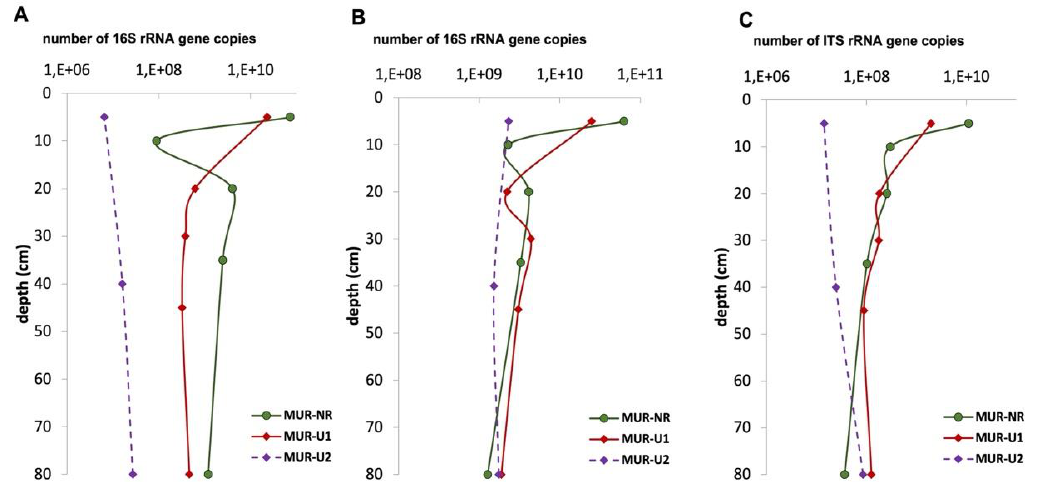
Figure 4. The number of 16S rRNA genes copies of archaea ( A ), bacteria ( B ), and ITS rRNA genes copies of fungi ( C ). Bacteria